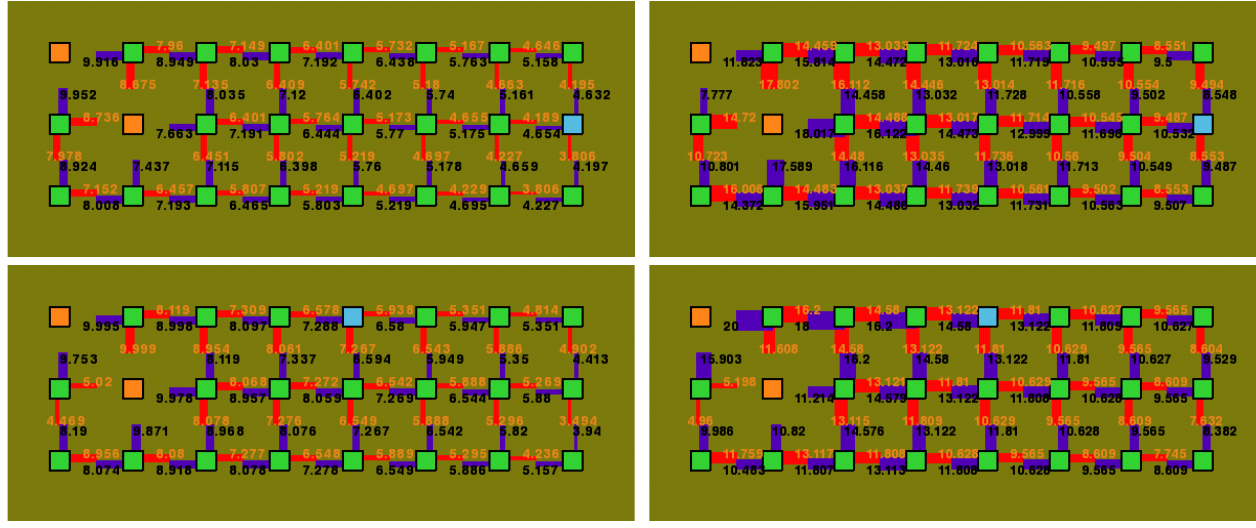
Figure 24: Q-value in maze 14 (upper left: agent A and internal reward gap is 0.1, lower left: agent B and internal reward gap is 0.1, upper right: agent A and internal reward gap is 10, lower right: agent B and internal reward gap is